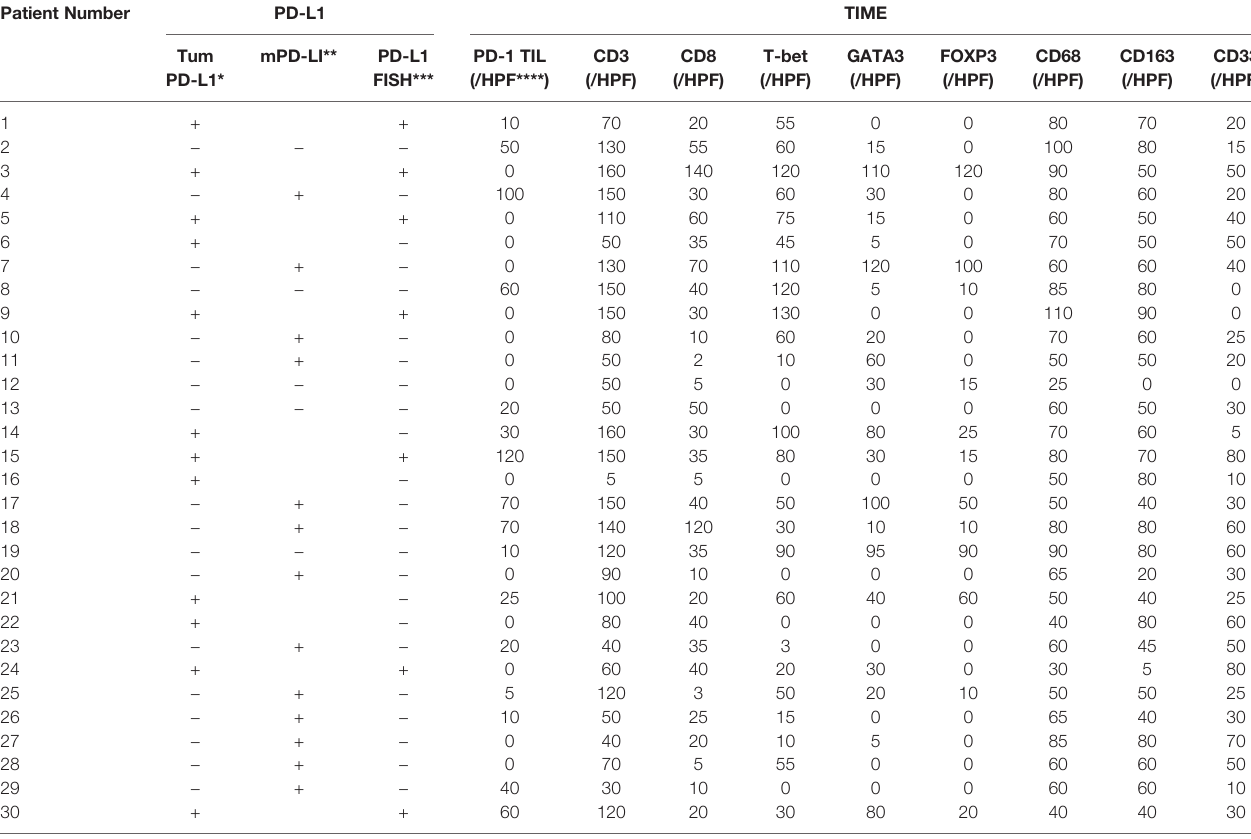
TABLE 2 | Immunohistochemical and FISH Analysis of 30 Patients with A-DLBCL. Patient Number